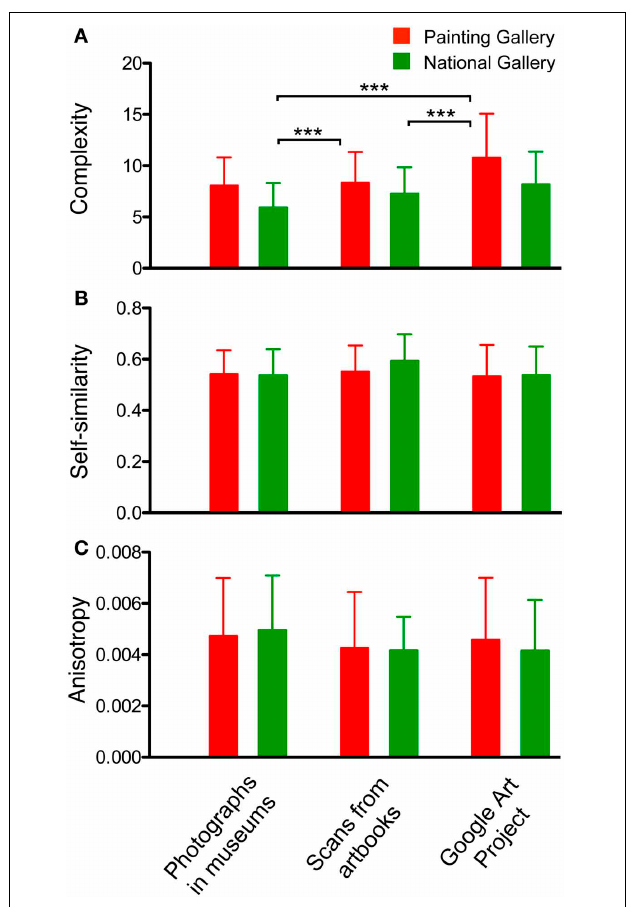
FIGURE 12 | Complexity (A), self-similarity (B) and anisotropy (C) of images of paintings (without frames). The three image categories analyzed were photographs of paintings, images of paintings scanned from art books and images of paintings downloaded from the Google Art Project, as indicated at the bottom for all panels. The same paintings from two museums (red, Painting Gallery; green, National Gallery) were analyzed. Values represent the mean ± SD . Differences are significant at p < 0 . 001 ( ∗∗∗ ), as